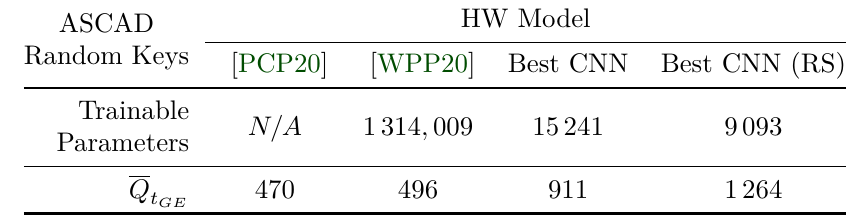
Table 4: Comparison of the top generated CNNs for the ASCAD with random keys HW leakage model experiments with the current